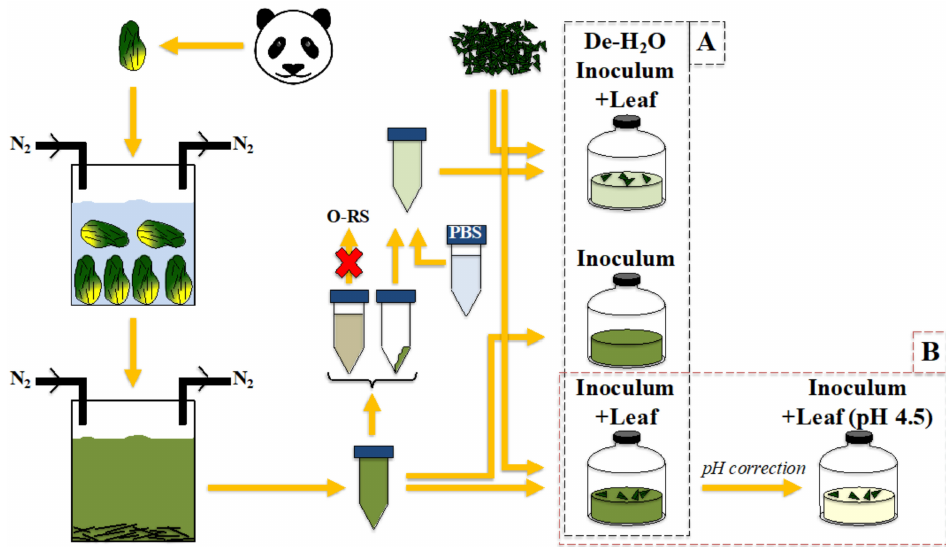
Figure 1. Experimental setup explaining how dung samples were treated to retrieve gut microbiomes and how they were incubated with or without the organics originally present in the fecal fluids, and with or without solid bamboo (i.e., leaf from P. bisettii ). Experiments aimed at testing fermentation kinetics and yields as a result of: ( A ) different feeding strategy—black, vertical rectangle; and ( B ) the impact of the initial pH—horizontal, red